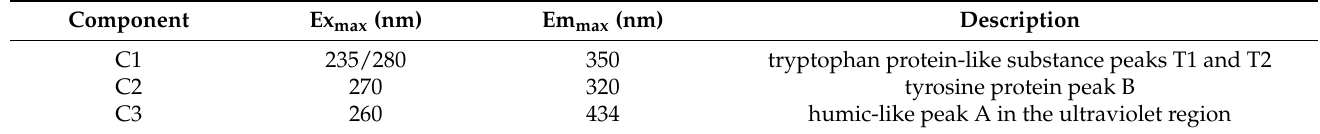
Table 3. Excitation and emission maxima of the fluorescent components of DOM identified in the overlying water by parallel factor (PARAFAC) modeling